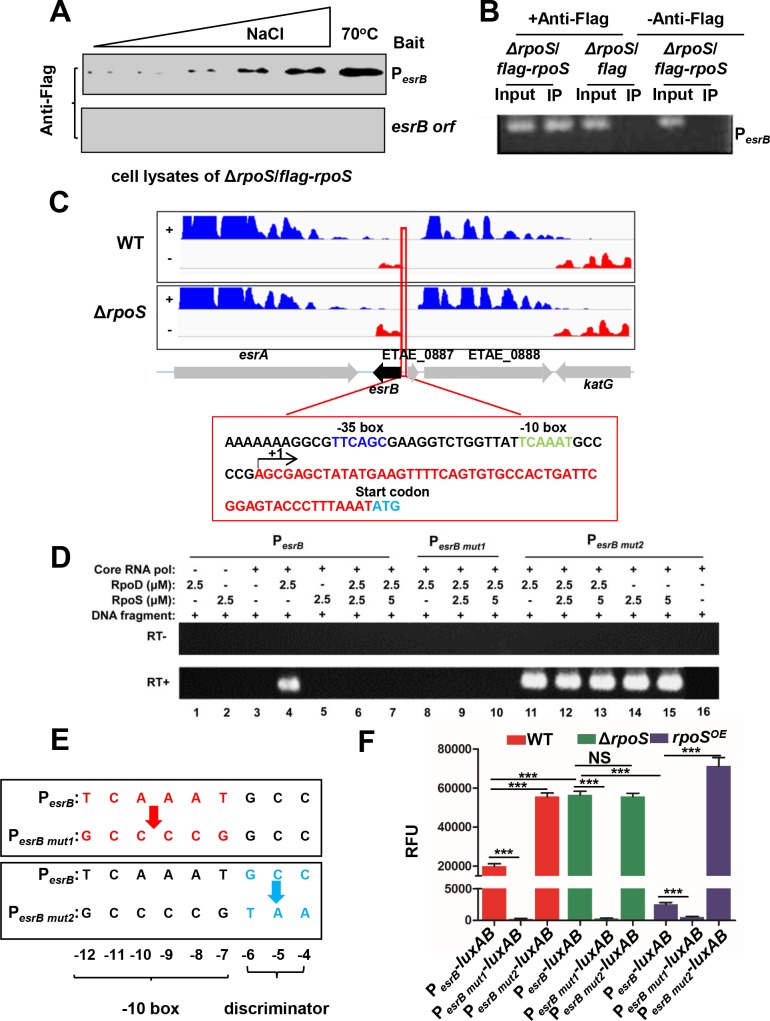
RpoS interacts with the esrB promoter region and inhibits esrB transcription in vitro.(A) Pull-down of RpoS by the promoter region of esrB (PesrB). DNA fragments containing PesrB or the esrB open reading frame (esrB orf) were labeled with biotin and fixed to agarose beads. The probe-labeled beads were then mixed with excess Poly (dI:dC) and lysates from ΔrpoS cells over-expressing Flag-tagged RpoS (ΔrpoS/flag-rpoS), washed, and eluted with a concentration gradient of NaCl and ultimately treated with ddH2O at 70°C to release bound proteins, followed by western blot analysis with an anti-Flag-specific monoclonal antibody. (B) ChIP assay analysis of RpoS binding to PesrB
in vivo. Stationary phase cells were cross-linked, washed, and sonicated to produce sheared chromosomal DNA. DNA was purified from the sheared pellets both before precipitation (input) and after precipitation in the presence (+) and absence (-) of the anti Flag antibody (IP). PCR was then used to amplify PesrB. (C) Normalized strand-specific-RNA-seq reads of esrB transcripts in ΔrpoS vs WT were used to identify the +1 site of the esrB transcript (depicted with an arrow). (D)
In vitro transcription reactions using templates containing PesrB, PesrB mut1 or PesrB mut2, NTPs, and E. coli RNAP core enzyme as well as E. piscicida RpoS and/or RpoD. Transcripts from the reactions were purified, reverse-transcribed (RT, +) and detected using PCR. As a control, the same purified transcripts were treated using the same process but without addition of reverse transcriptase (RT, -). (E) Schematic of two engineered variants of the esrB promoter; PesrB mut1 contains substitutions in the -10 box and PesrB mut2 contains substitutions in the neighboring discriminator GCC sequence. (F) Fluorescence values from WT, ΔrpoS, and rpoSOE strains with chromosomal luxAB reporter driven by PesrB, PesrB mut1 or PesrB mut2. *** P < 0.0001, NS, non-significance (P >0.05) based on student’s t-test.